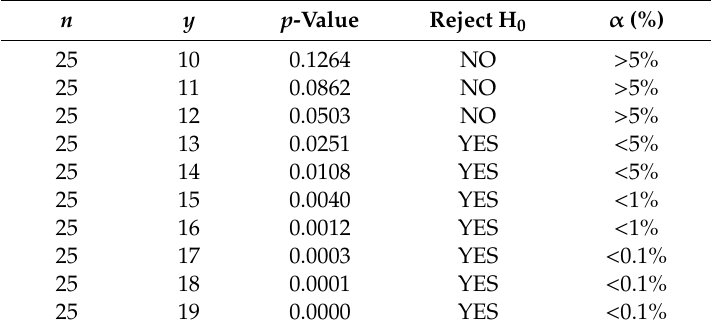
Table 5. Calculation of the p -value for a hypothesis contrast using the binomial distribution and comparison to the chosen level of significance ( α =